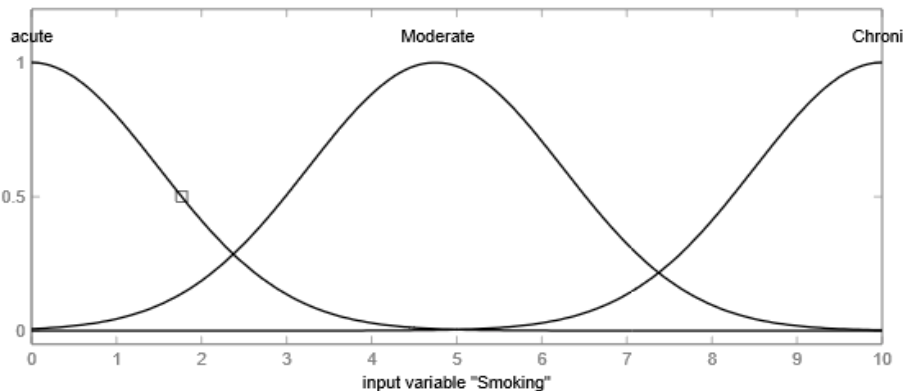
Figure 5. Membership Functions of input variable “Smoking”.